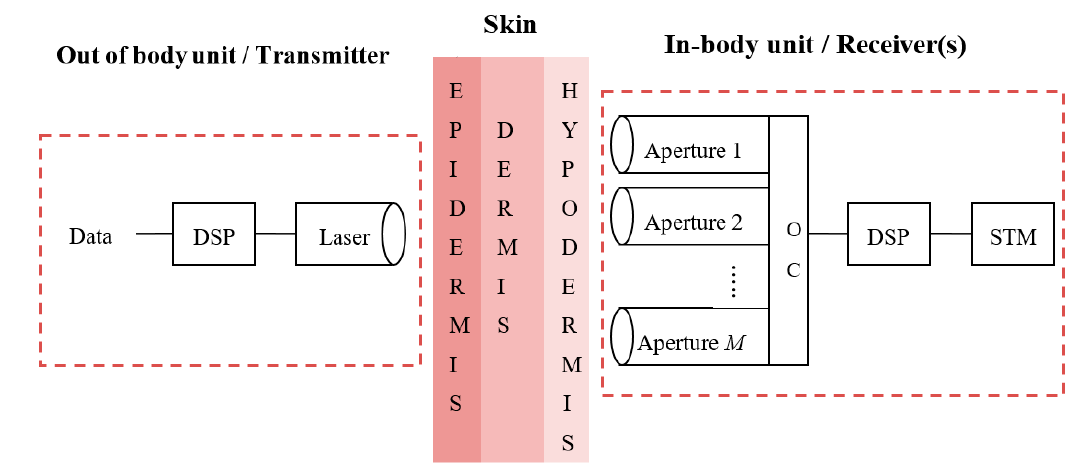
Figure 1. Block diagram of the proposed TOW system.